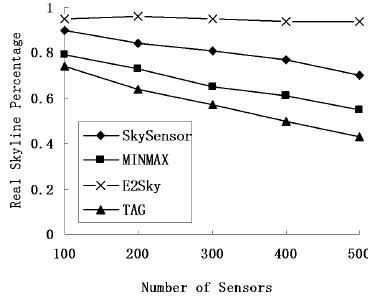
Figure 8. Real skyline percentage under a different number of sensors.